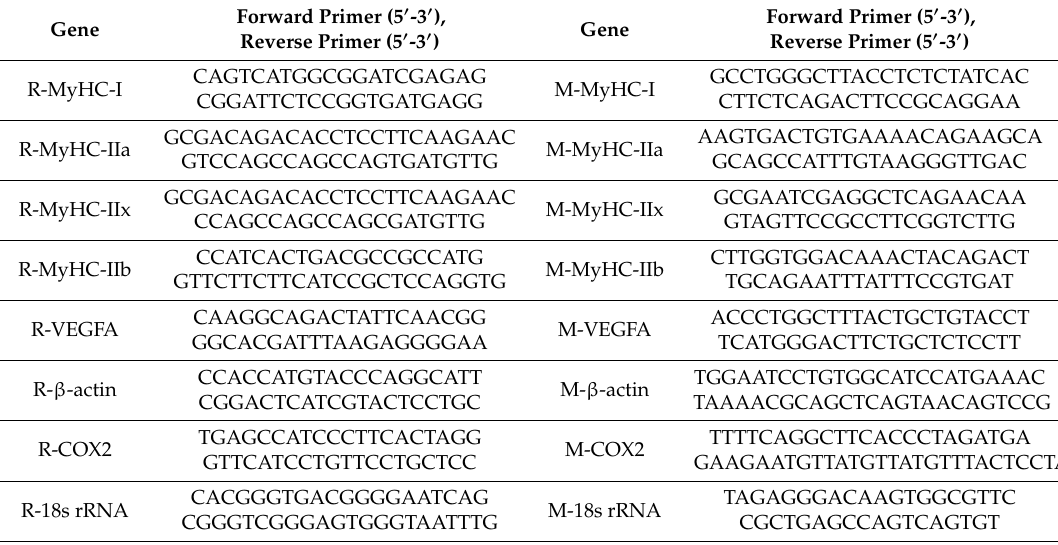
Table 1. Primer sets for